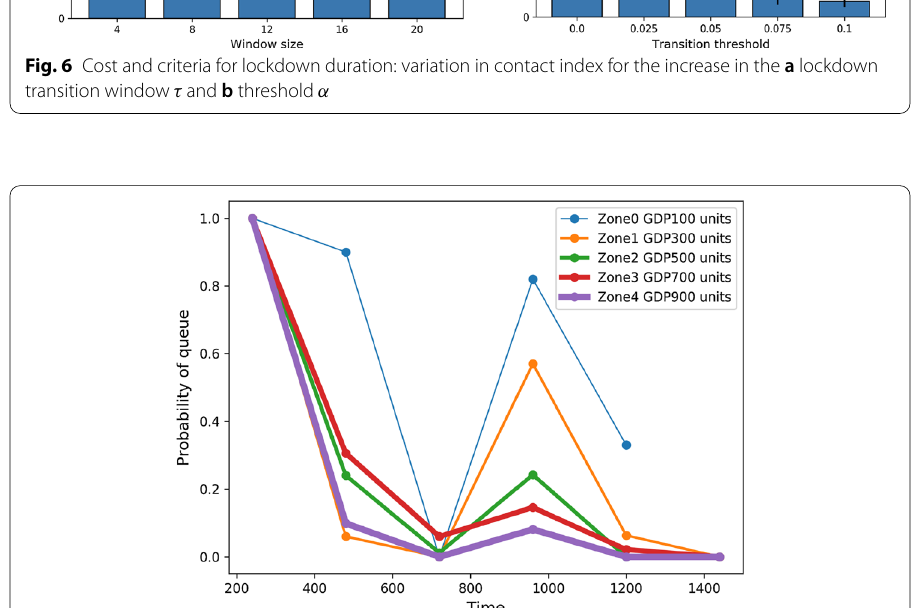
Fig. 7 Probability of queues for identical zones, only varying in healthcare resource budget (measured in terms of